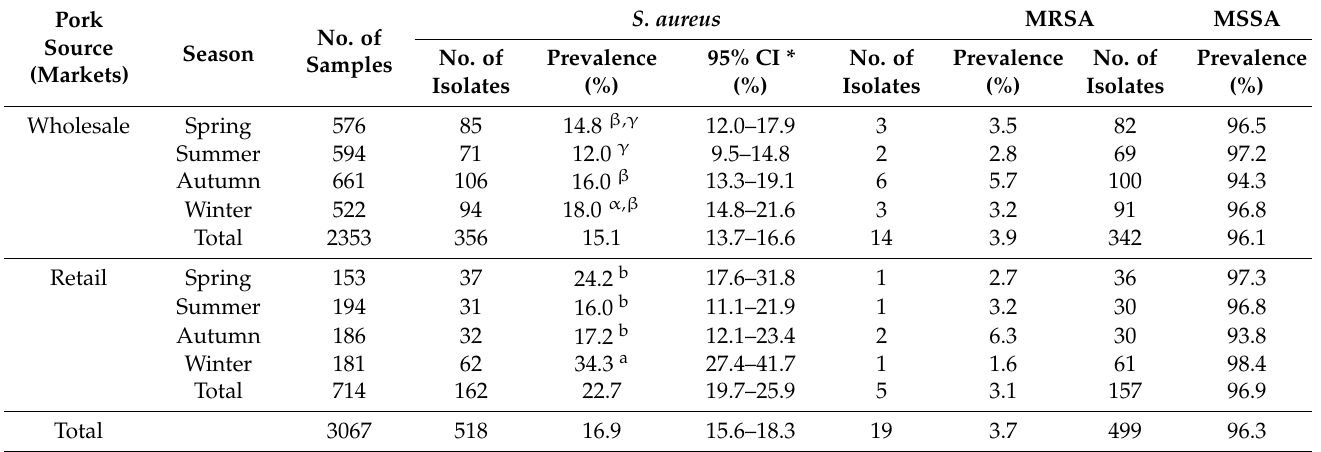
Table 1. Overview of S. aureus prevalence in wholesale and retail pork in Wuhan, central